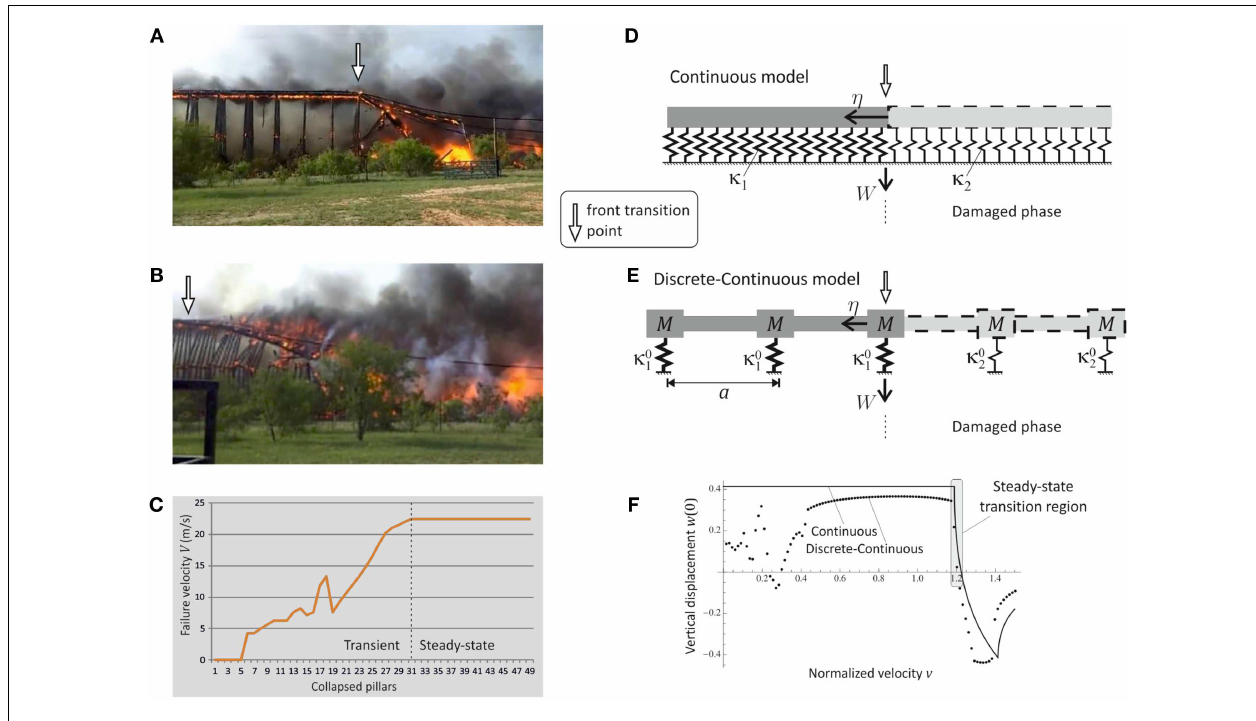
and after failure, respectively]. (E) Discrete–continuous model on discrete elastic foundation [participating mass M (kg), and stiffness κ 0 (N/m)]. 1,2 (F) Normalized vertical displacement w at the transition point η = 0 as a function of the normalized velocity v for the continuous (D) and discrete–continuous (E) structural models (see the Section “Three Dynamic Regimes of InterfacialWaves” in Supplementary Material for the normalization). Steady-state propagation of the failure is possible only in the intersonic velocity interval 4 (cid:112) 4 κ 2 /κ 1 < V /(ξ/τ) < (cid:112) ( 1 + κ 2 /κ 1 )